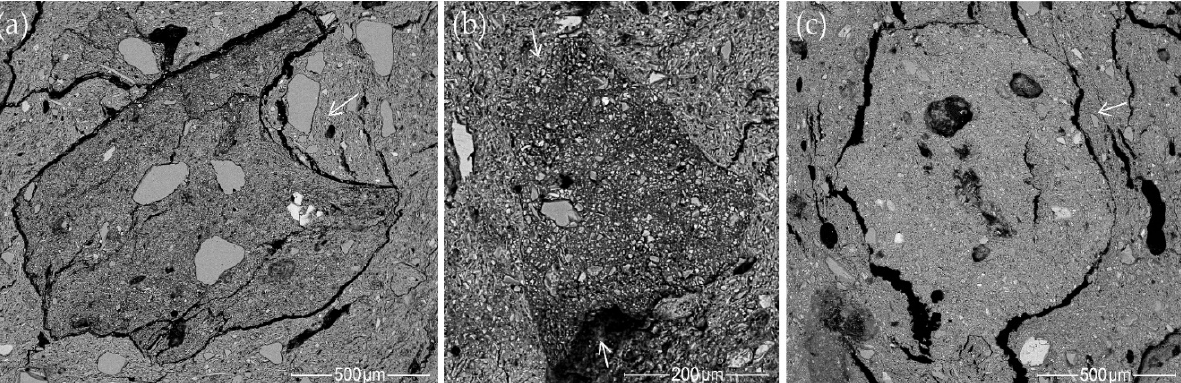
Figure 18. SEM BSE images of the dark clay matrix containing light-colored clay pellets. Arrows show a direction mechanical deformation made in processing the clay body: ( a ) CW-E_M2, a clay pellet with Mg and Fe rich hornblende (white fragments); ( b ) CW-E_M2, diffused boundaries of the clay pellet rich in quartz and K-feldspar grains; ( c ) CW-E_M3, only contraction voids mark boundaries of the clay pellet.